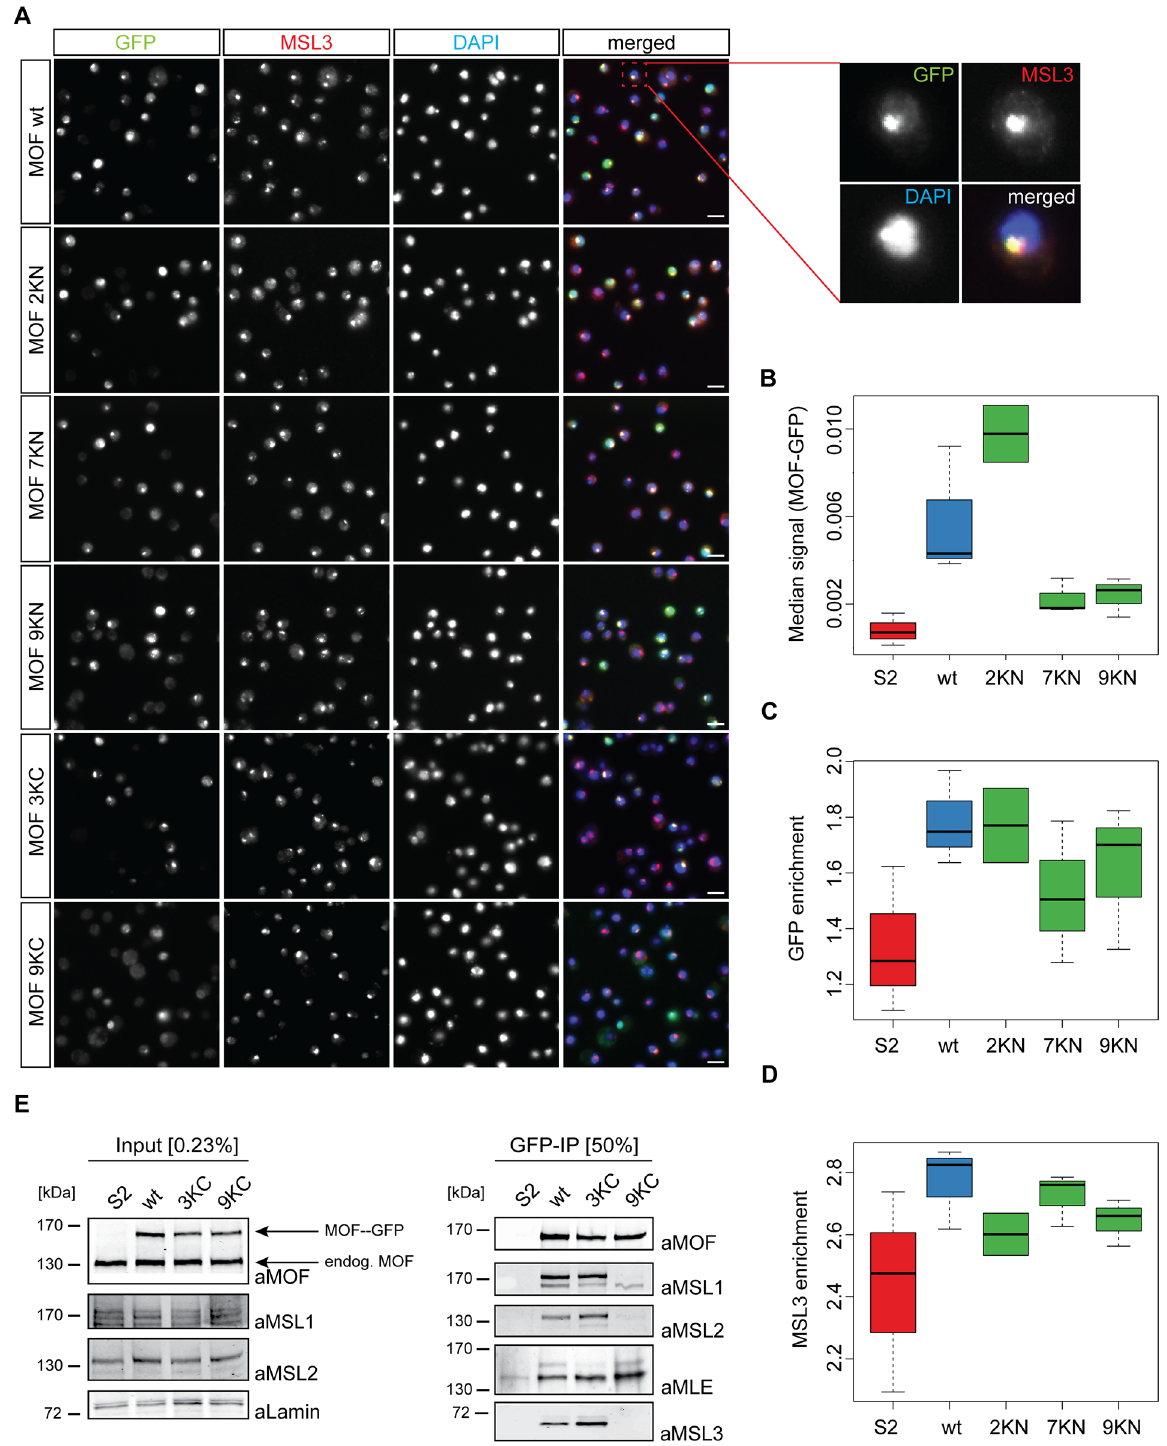
Fig 3. Characterization of MOF mutants in cells. (A) Nuclearlocalization of MOF point mutants after depletionof endogenous MOF. Stable cell lines expressingeither MOF-GFP wt or MOF-GFP bearing the indicatedpoint mutants were stainedwith antibodies againstGFP and MSL3 as indicated.DNA was counterstained with DAPI. The GFP stainingreveals the localization of the ectopic MOF, whereasMSL3 stainingprovides a reference for the X chromosometerritory and for possibledominant negativeeffects of MOF mutants. The experiment was carried out in three biologicalreplicates for MOF wt, 7KN and 9KN, 2 biologicalreplicatesare shown for